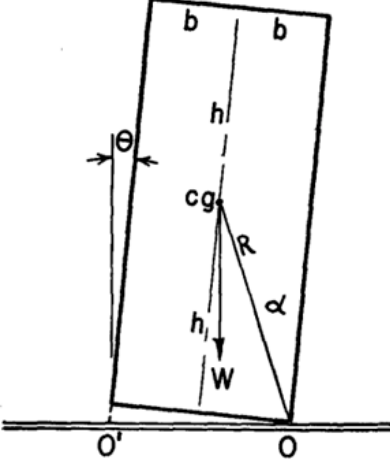
Figure 1. Rocking Block after Housner [1].